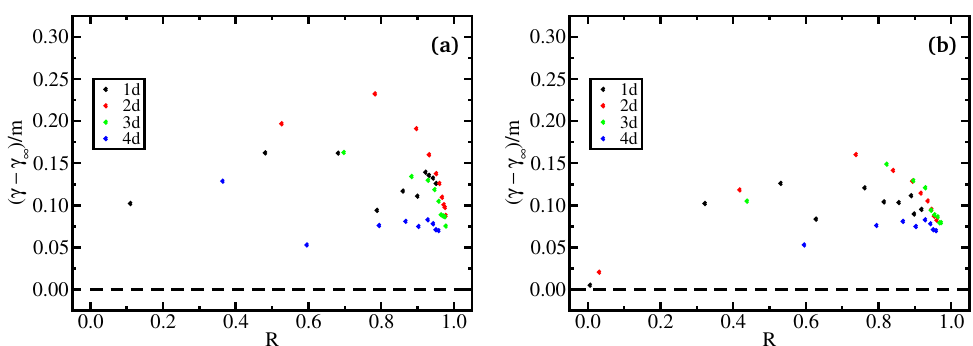
Figure 6: Deviations from the d → ∞ value of the ( R , γ ) curve of the LJ ( 4 d ,2 d ) potential for dimensions d = 1 to 4, using dimension-scaled densities. (a) Densities ( d ) (first line of Tab. 2); scaled by the hard-sphere dynamical transition density ρ HS d ρ = 0.577, ρ = 0.587, ρ = 0.629, and ρ = 0.750. (b) Densities d = 1 d = 2 d = 3 d = 4 ( d , T ) obtained by equating the second and third virial expansion terms scaled by ρ Z = 0.415, ρ = 0.469, ρ = 0.577 and (second line of Tab. 2). Specifically, ρ d = 1 d = 2 d = 3 ρ = d = 4